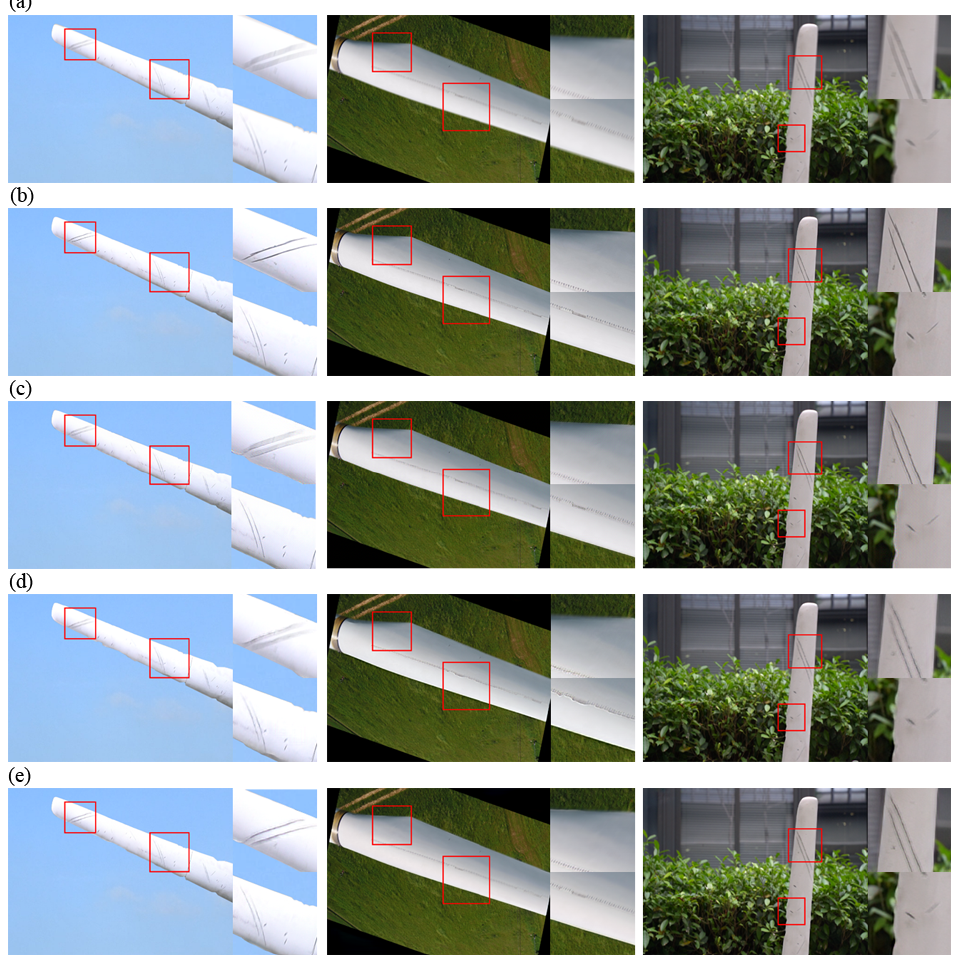
Figure 12. Motion deblurring results for images captured with a rotational angular velocity of 0–2 rad/s (the blur length increases from left to right column): ( a ) Blurred images; ( b ) Sharp images; ( c ) Restored images using the DeblurGAN; ( d ) Restored images using the M-DeblurGANv2; ( e ) Restored images using the I-DeblurGANv2.